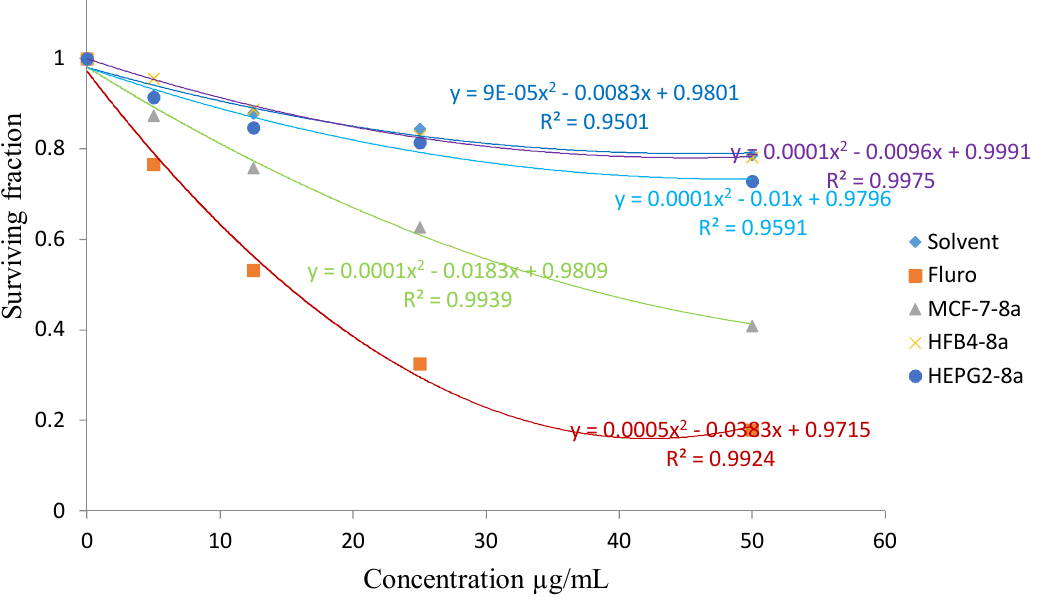
Figure 2. The cytotoxic activity of the synthesized product 8a against breast MCF7 cancer cell line.